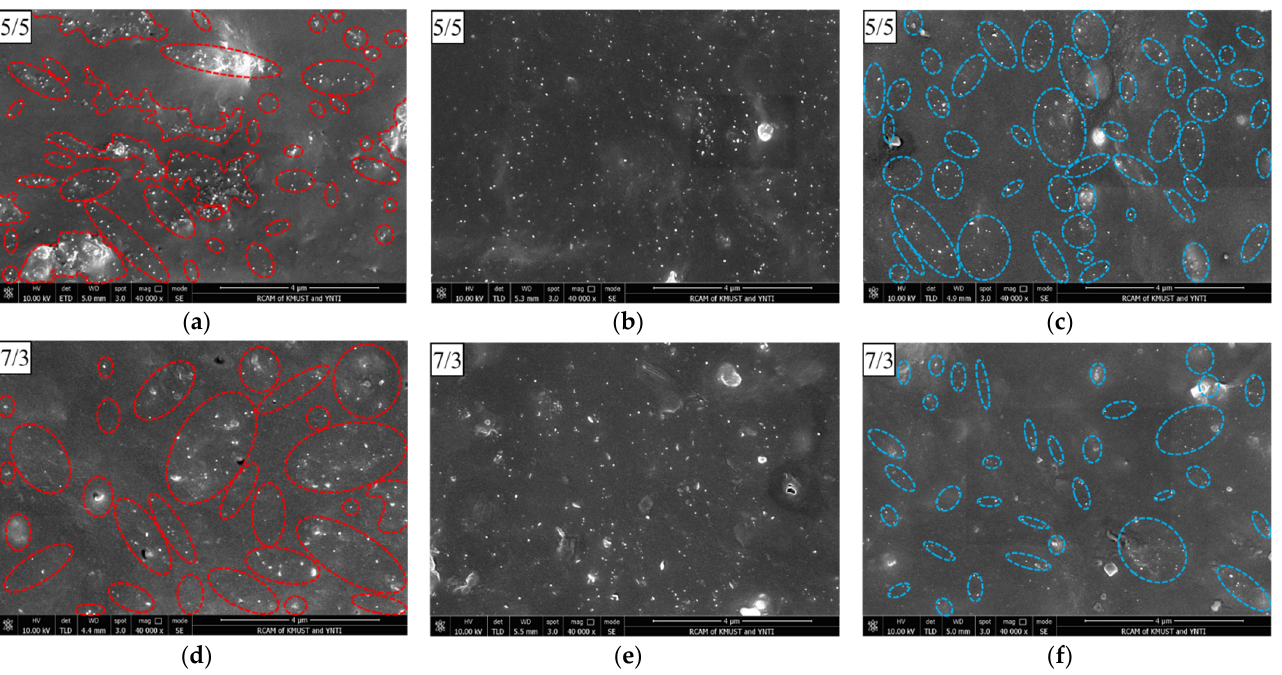
Figure 9. SEM images of MWCNT/CR − NR composites with different blending processes: the red − circled areas are the CR − MWCNT conductive phase, and the blue − circled areas are the NR − MWCNT conductive phase. (( a ) CR − 6CNT/NR 5/5, ( b ) CR − 3CNT/NR − 3CNT 5/5, ( c ) CR/NR − 6CNT 5/5, ( d ) CR − 6CNT/NR 7/3, ( e ) CR − 3CNT/NR − 3CNT 7/3, and ( f ) CR/NR − 6CNT 7/3).